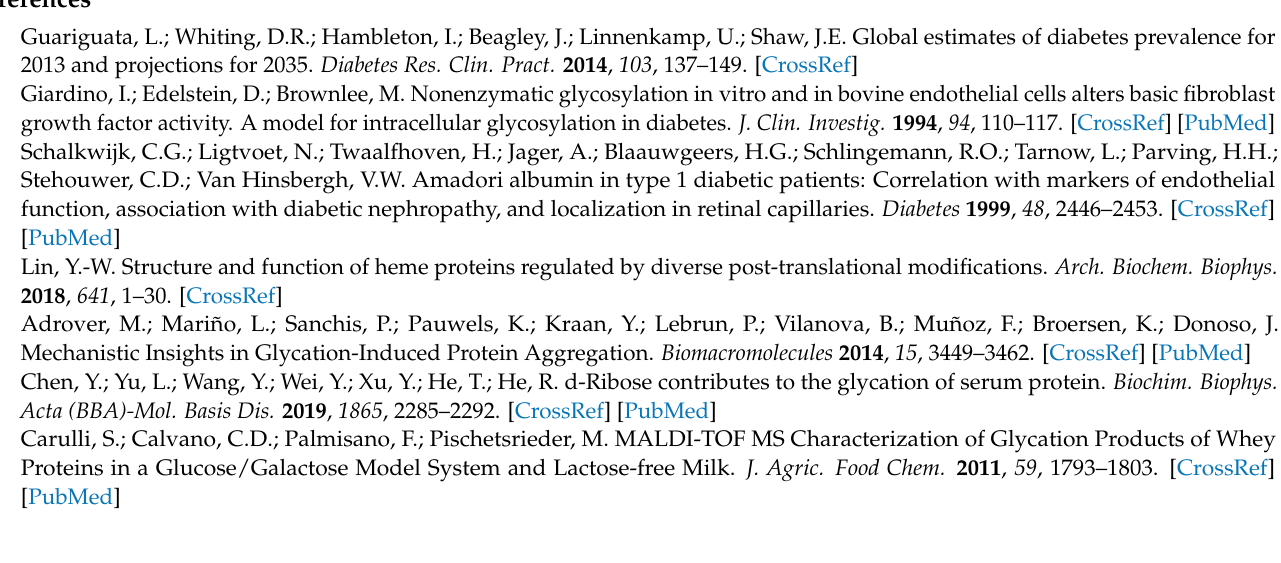
Supplementary Materials: The following are available online. Figure S1: The UV-Vis spectra of HMb incubated with D -ribose and D -glucose; Figure S2: The ESI-MS spectrum of the expressed and purified HMb; Figure S3: The original multiply charged series in the ESI-MS spectra of the HMb after reacting with the D -ribose at different hours; Figure S4: The ESI-MS spectra and the extracted ion chromatograms of trypsin digestion products of the HMb reacted with the D -ribose for 0, 2 or 4 h; Table S1: The relative errors in mass determination relative to the theoretical values as analyzed in Figure 2; and Table S2: The results of the peptide MS/MS analysis with